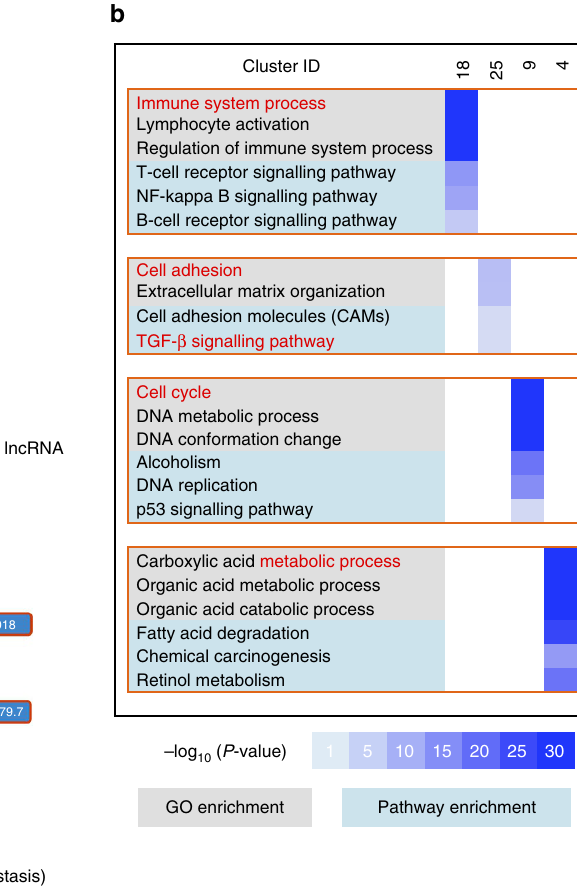
qRT-PCR (Fig. 6b, Supplementary Fig. 12, Supplementary Table 4). The results from three representative transwell assays are shown on the right side of the figure (Fig. 6c,d).